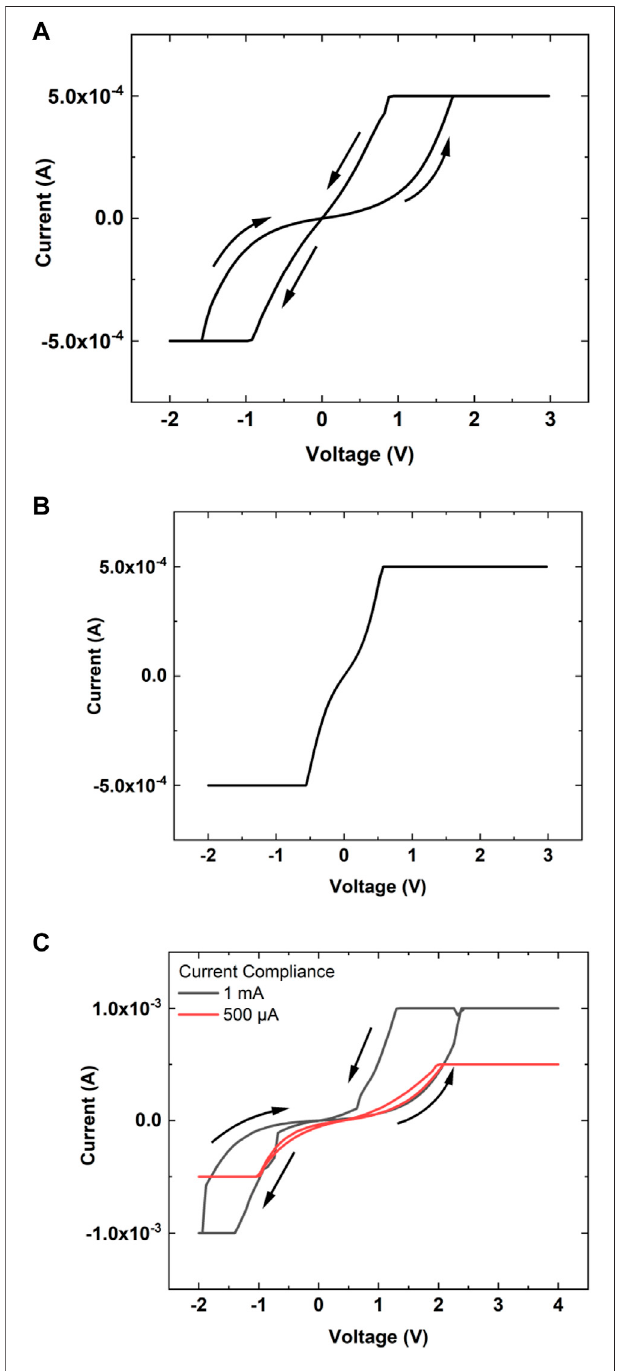
FIGURE 2 | Plot of the I-V characteristic GeTe memristor showing switching behavior in the form of a hysteresis loop (A) and pinched hysteresis (B,C) DC voltage sweep at 500 µA current compliance after cycling at 1 mA (red) and a DC voltage sweep at 1 mA after the 500 µA sweep